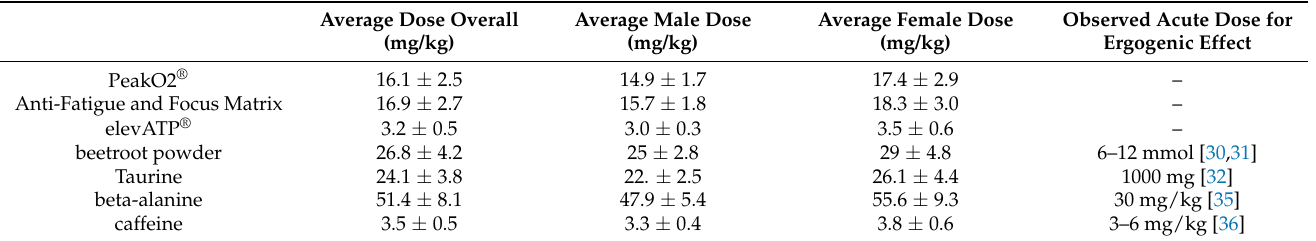
Table 2. Relative doses of supplement components. Data are presented as mean ± SD. Average Dose Overall Average Male Dose Average Female Dose Observed Acute Dose for (mg/kg) (mg/kg) (mg/kg) Ergogenic Effect PeakO2 ® 16.1 ± 2.5 elevATP